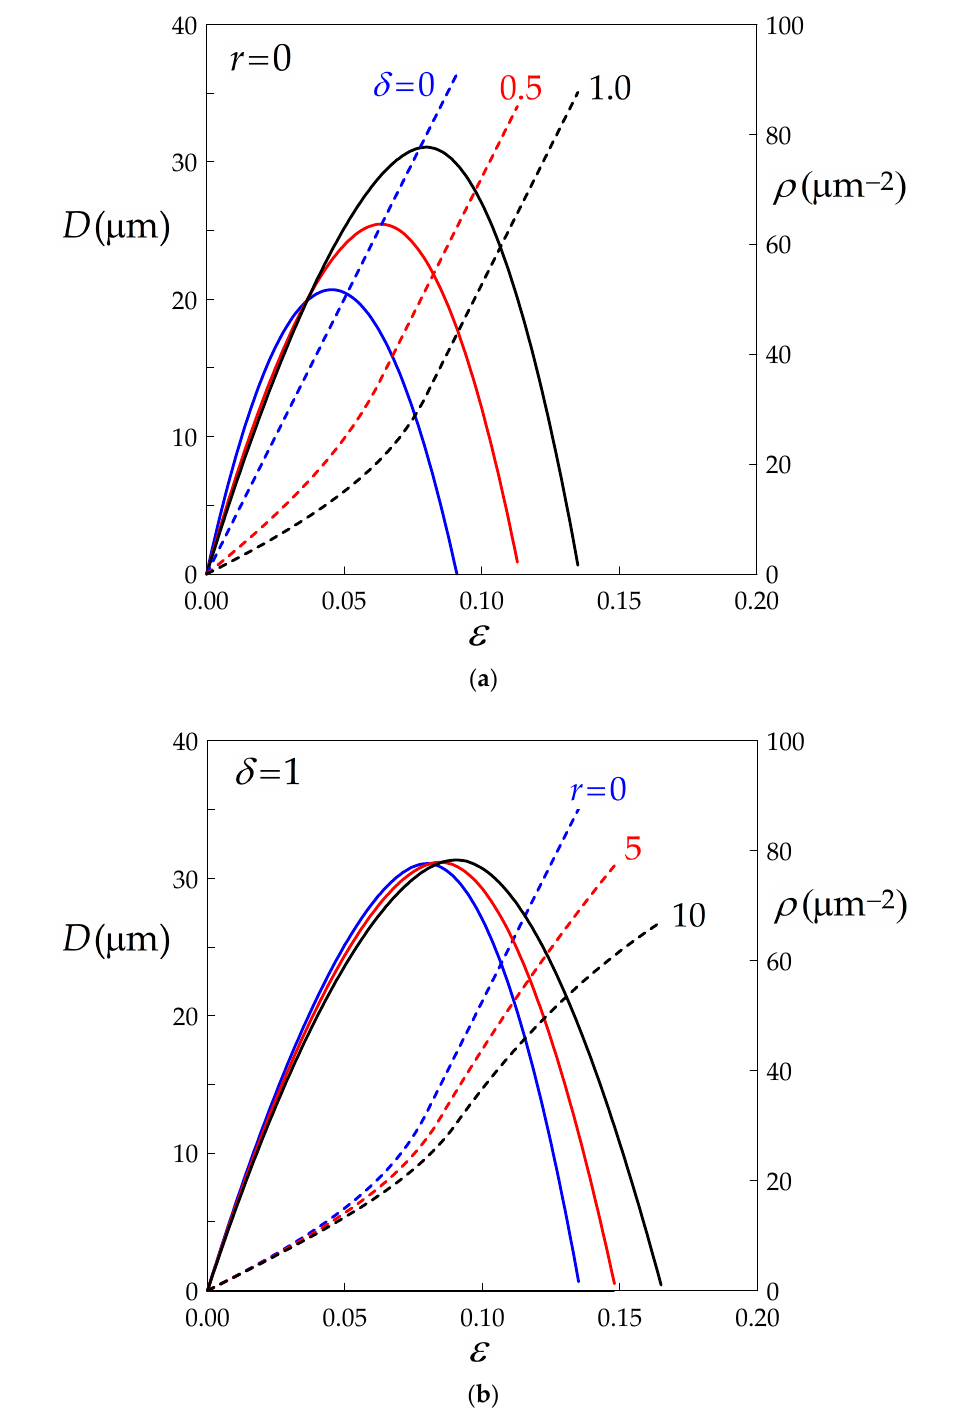
Figure 6. Strain dependence of the grain size (solid lines) and dislocation density (broken lines) for any grain in the aggregate; ( a ) No dynamic recovery: influence of BMIS; ( b ) Full BMIS: influence of dynamic recovery.